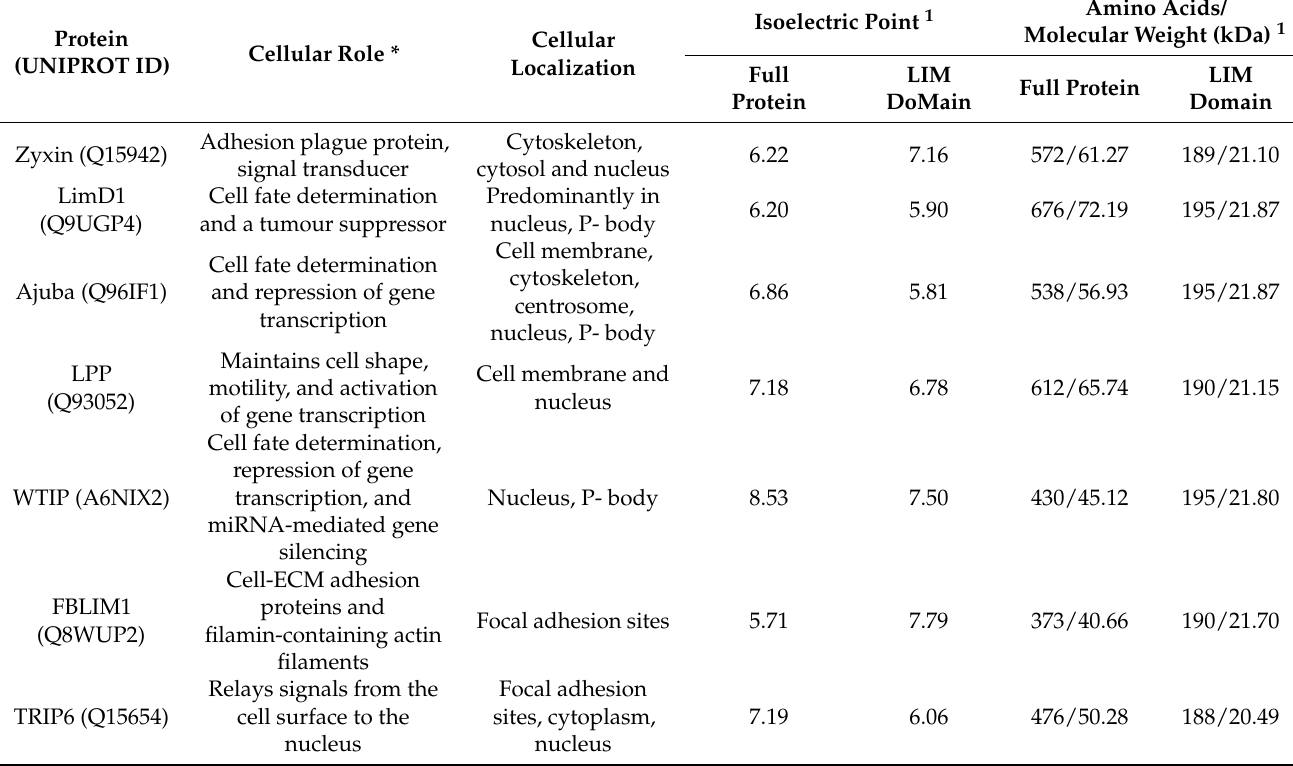
Table 1. List of Zyxin family proteins containing LIM domain, their functions and biochemical properties.